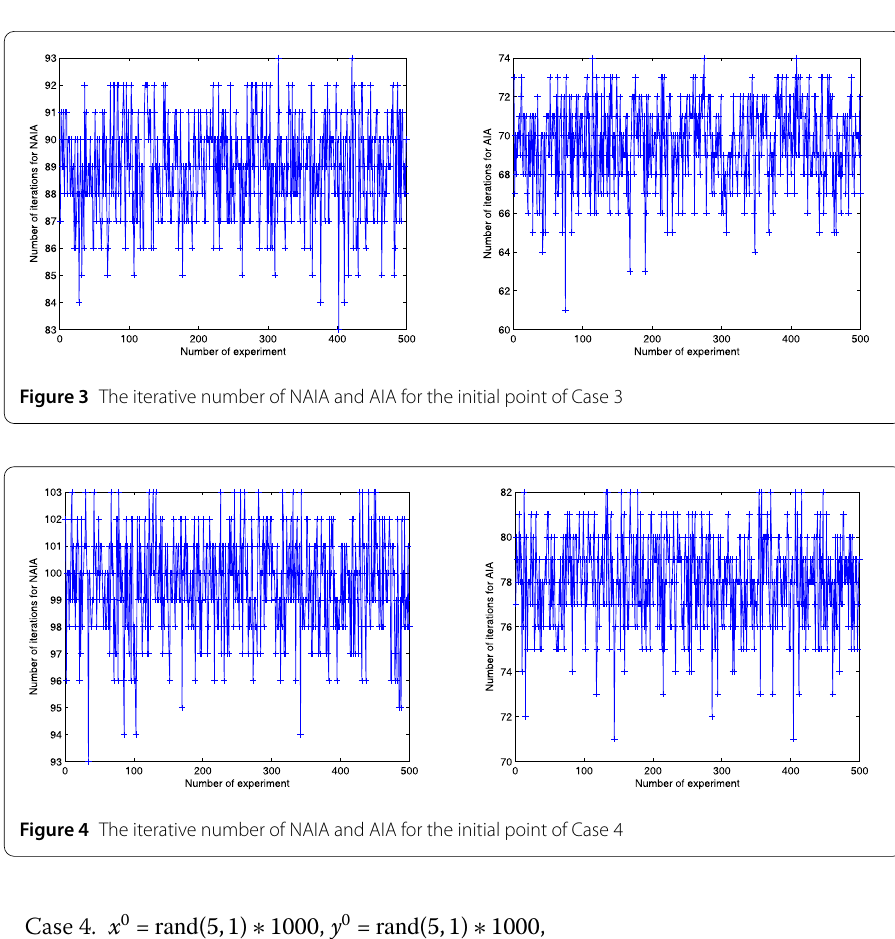
Case 4. x 0 = rand (5,1) ∗ 1000 , y 0 = rand (5,1) ∗ 1000